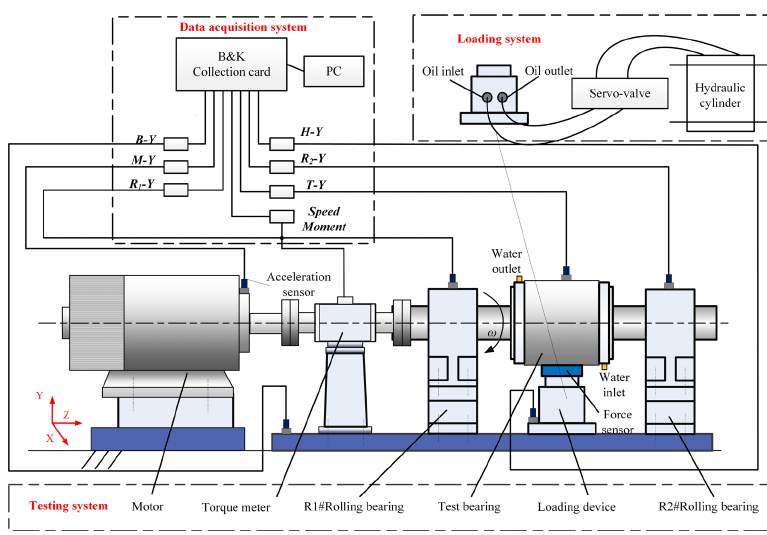
Figure 7. Structural view of the test rig.